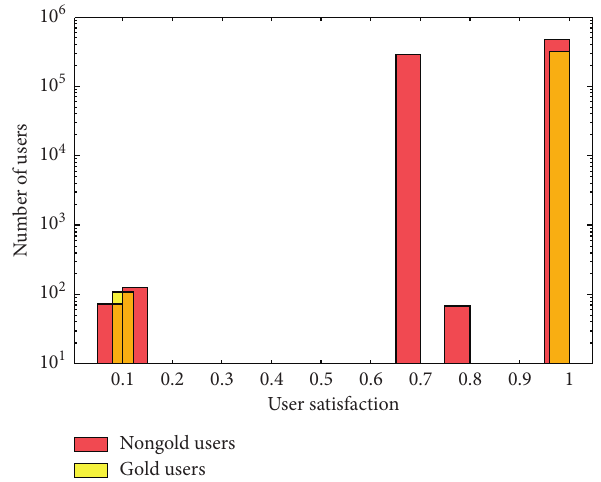
Figure 9: Simulated average customer satisfaction with 30% gold users.